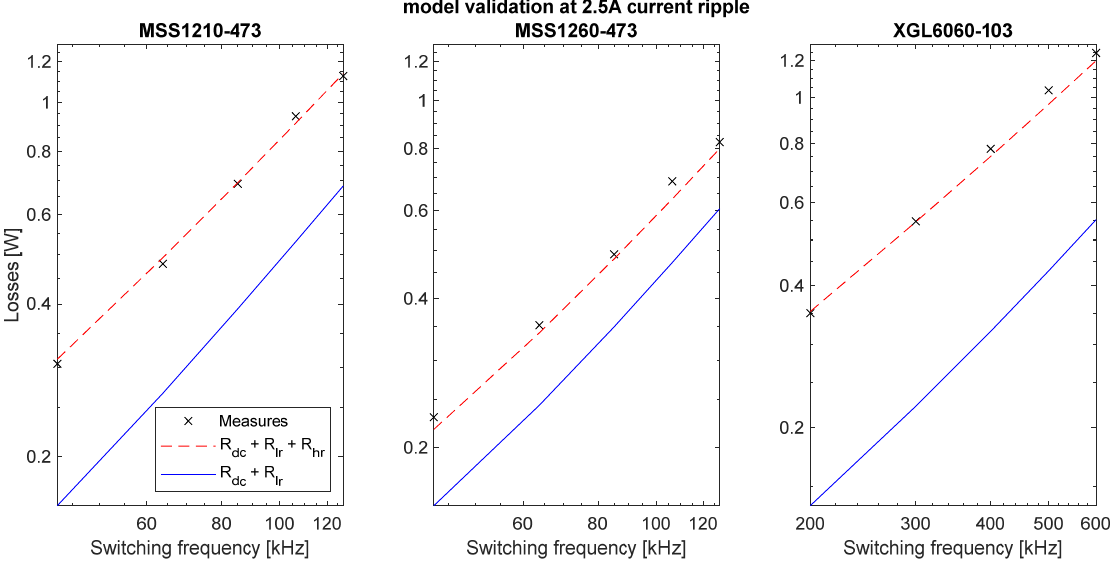
Table 2. Series resistance model parameters for the three manufacturer inductor series.